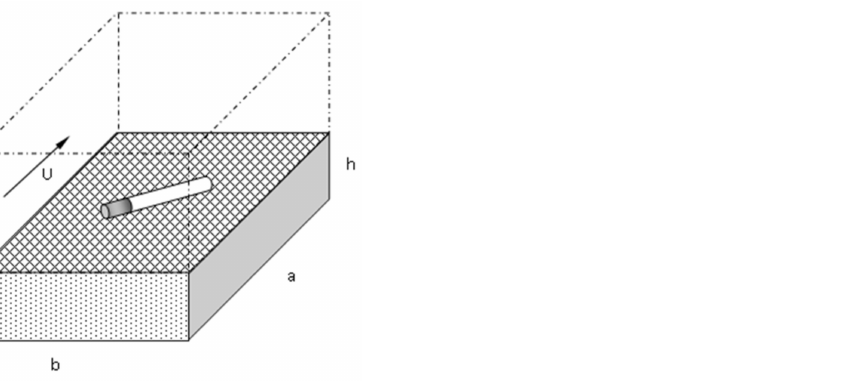
Figure 1. General view of the control volume of the system composed of a cigarette, the fuel bed and the surrounding